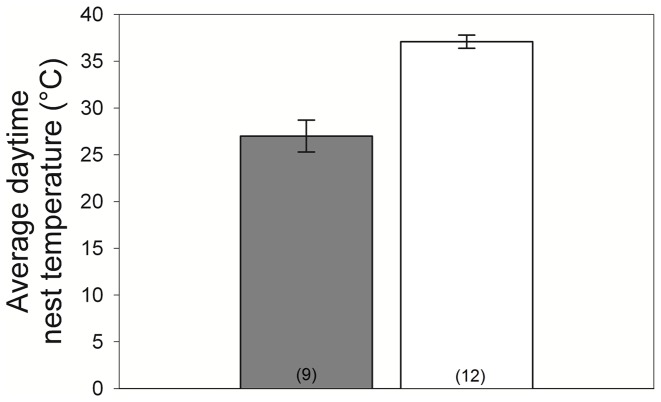
Incubation.Testosterone-implanted females’ nests (shaded bar) were significantly cooler than control females’ nests (open bar). Sample sizes are shown in parentheses; error bars represent the standard error of the mean.